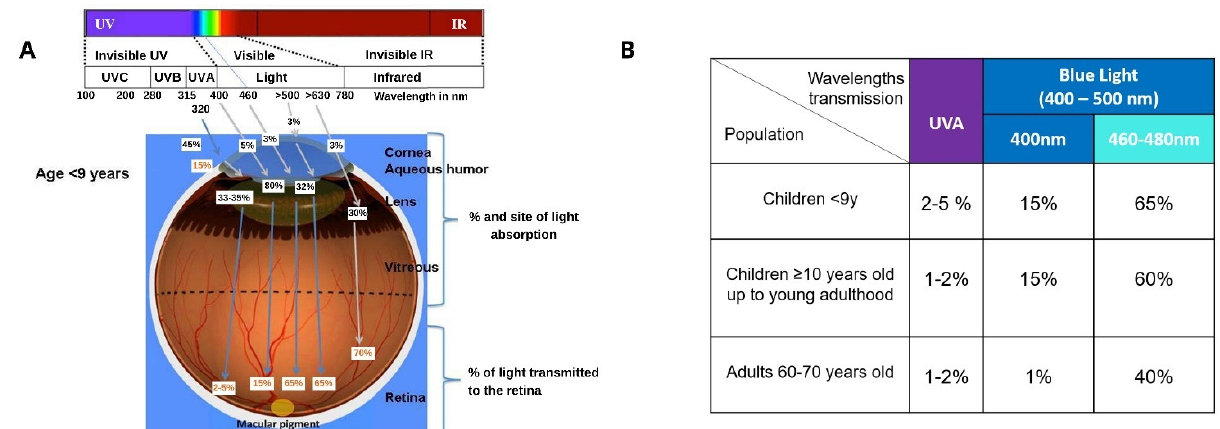
Figure 3. ( A ) Specificity of light interaction with the eye of children below the age of 9 years in agreement with ANSES. (reproduced from SCENIHR 2012 [18]). ( B ) Transmission of ultraviolet A (UVA) and blue light to the retina of <9 years old, children 10 years old up to young adulthood and the eye of a 60–70 years old adult in agreement with ANSES.